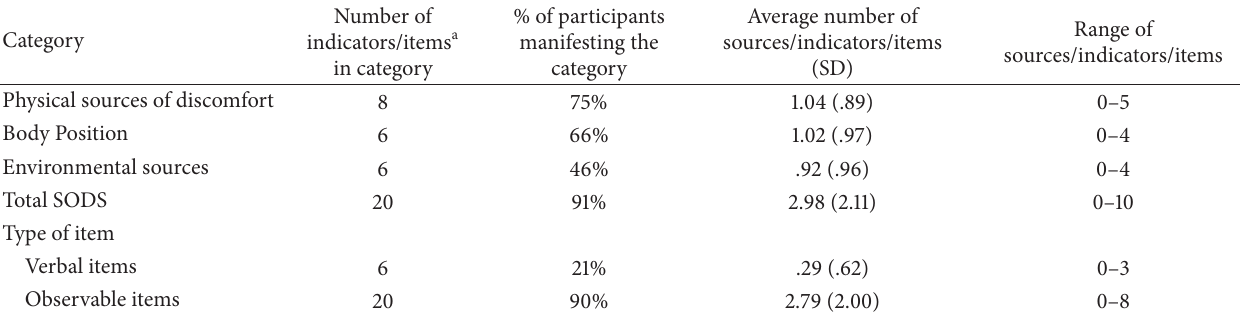
Table 2: Distribution of categories of sources and indicators of discomfort based on the Sources of Discomfort Scale.